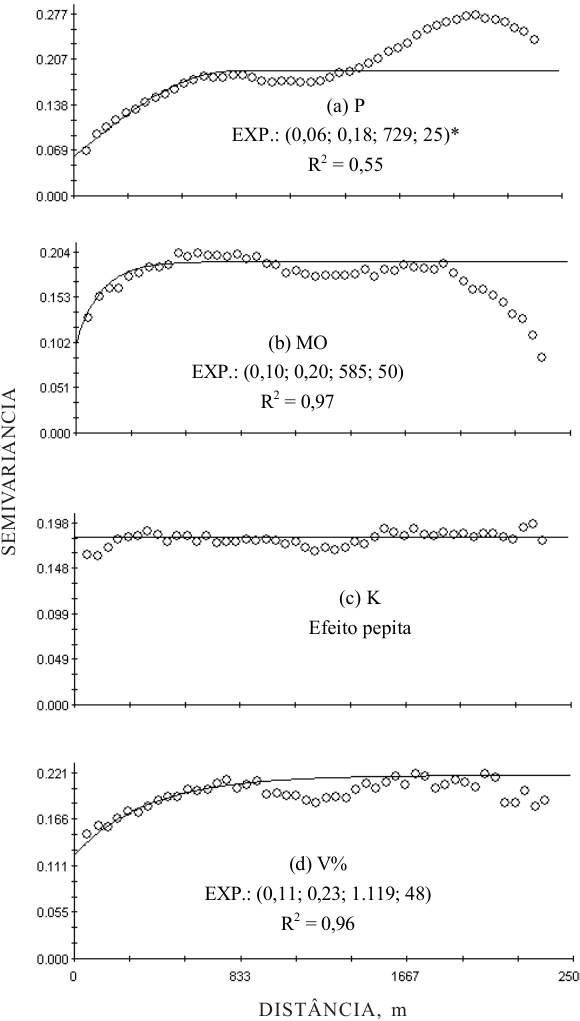
Figura 3. Semivariogramas das variáveis indicadoras, quando se utilizaram, como valores de corte, os valores do 2 o quartil: (a) fósforo; (b) matéria orgânica; (c) potássio e (d) saturação por